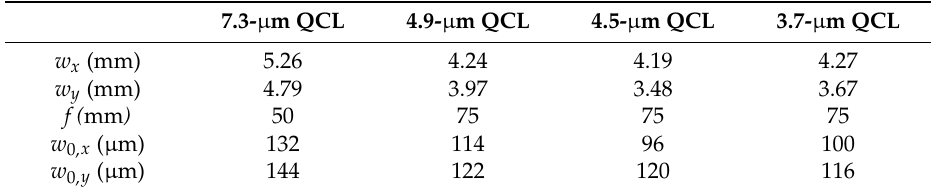
Table 1. w x and w y values calculated by using the second-order moments method; w 0, x and w 0, y values calculated from Equation (3) when a coupling lens with a focal length f is employed.